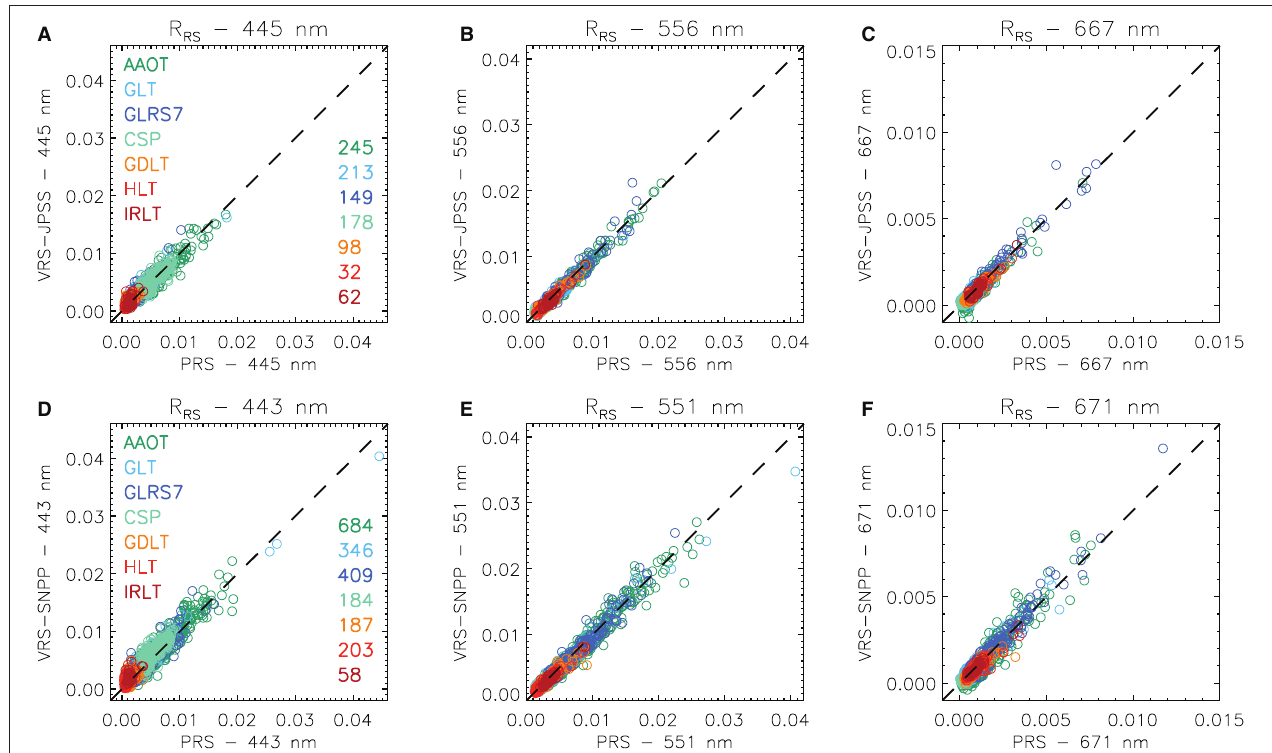
FIGURE 3 | Scatter plots of R RS match-ups with respect to AERONET-OC PRS data for VIIRS-JPSS1 (A–C) and VIIRS-SNPP (D–F) at selected wavelengths. Acronyms refer to AERONET-OC sites (see text). Numbers indicate the number of match-ups for each site.